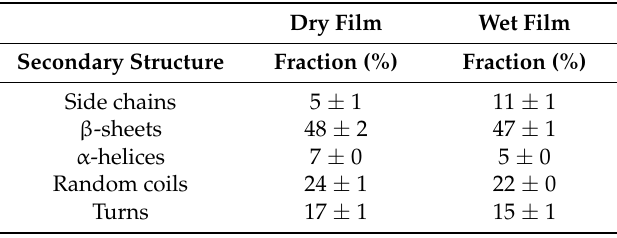
Figure 5. Scanning electron microscopy (SEM) images of self ‐ assembled ChryC1 films. Scale bars: 100 μ m and 2 μ m (inset), respectively. Table 1. Content of secondary structures in ChryC1 films as evaluated by Fourier self ‐ deconvolution. The data represent mean values obtained from two protein films ± standard deviation. All values are rounded to whole numbers.